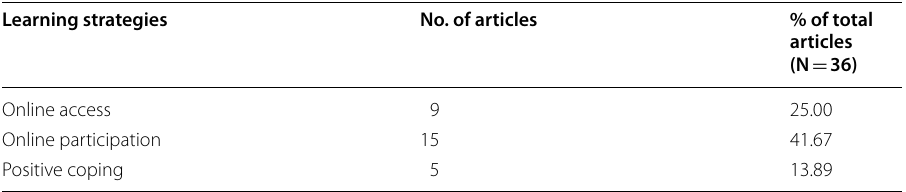
Table 4 Learning strategies Learning